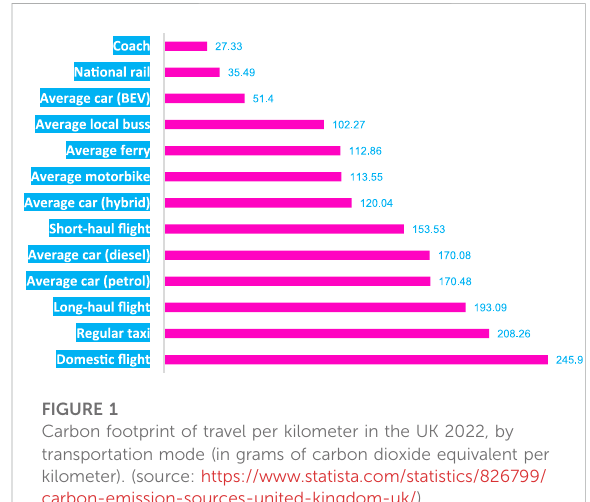
FIGURE 1 Carbon footprint of travel per kilometer in the UK 2022, by transportation mode (in grams of carbon dioxide equivalent per kilometer). (source: https://www.statista.com/statistics/826799/